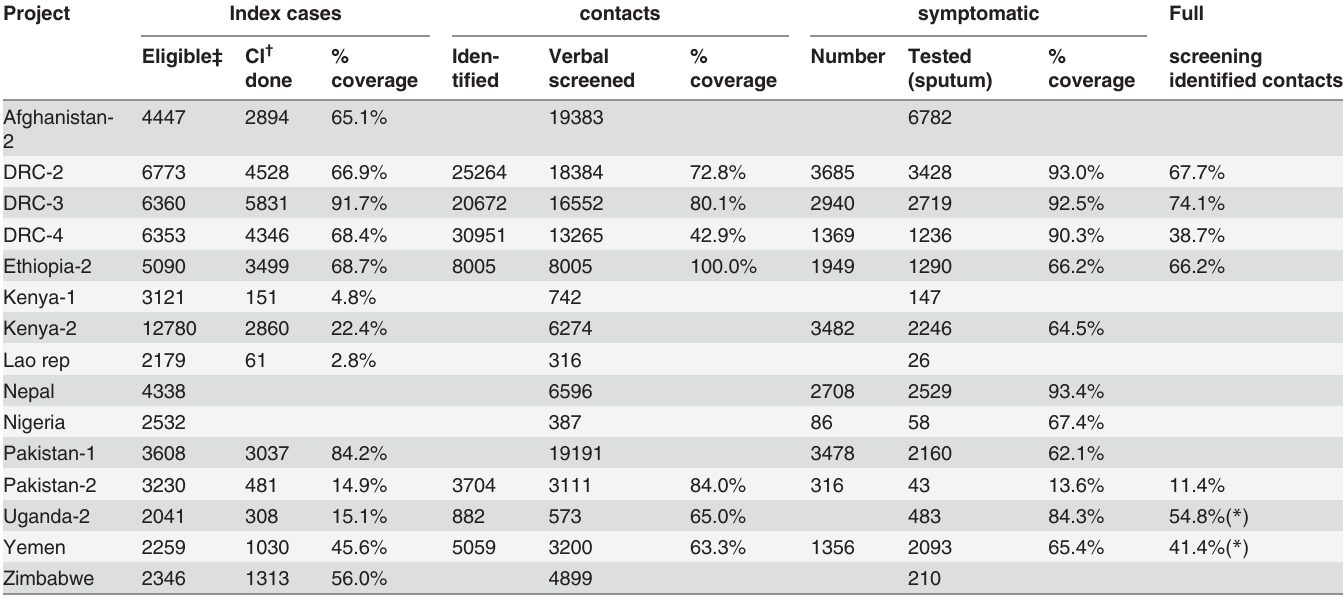
Table 4. Coverage of contact screening (n = 15).